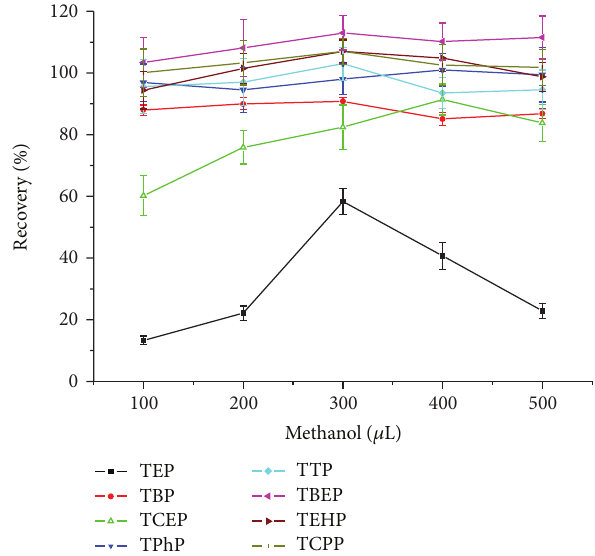
Figure 6: Optimization of dispersant volume.